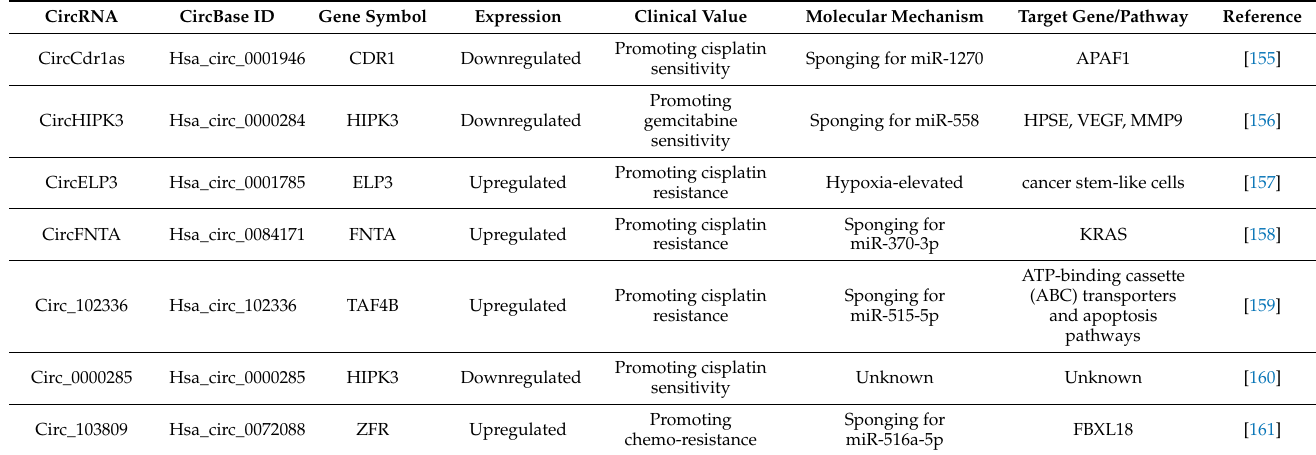
Table 2. circRNAs and their values in bladder cancer chemo-sensitization and